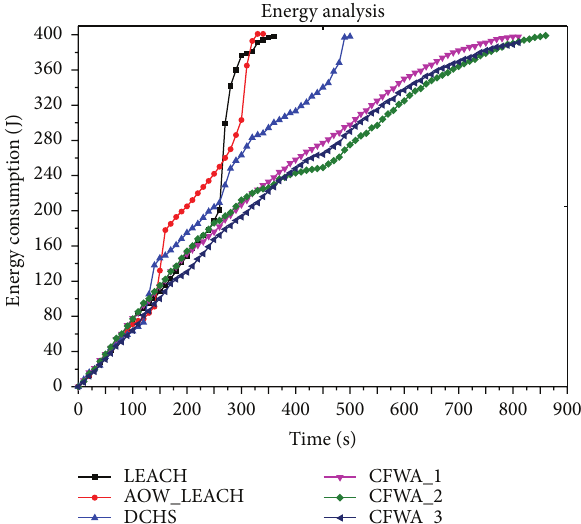
Figure 9: Energy analysis chart between CFWA family algorithms and LEACH-like algorithms in 200 nodes.